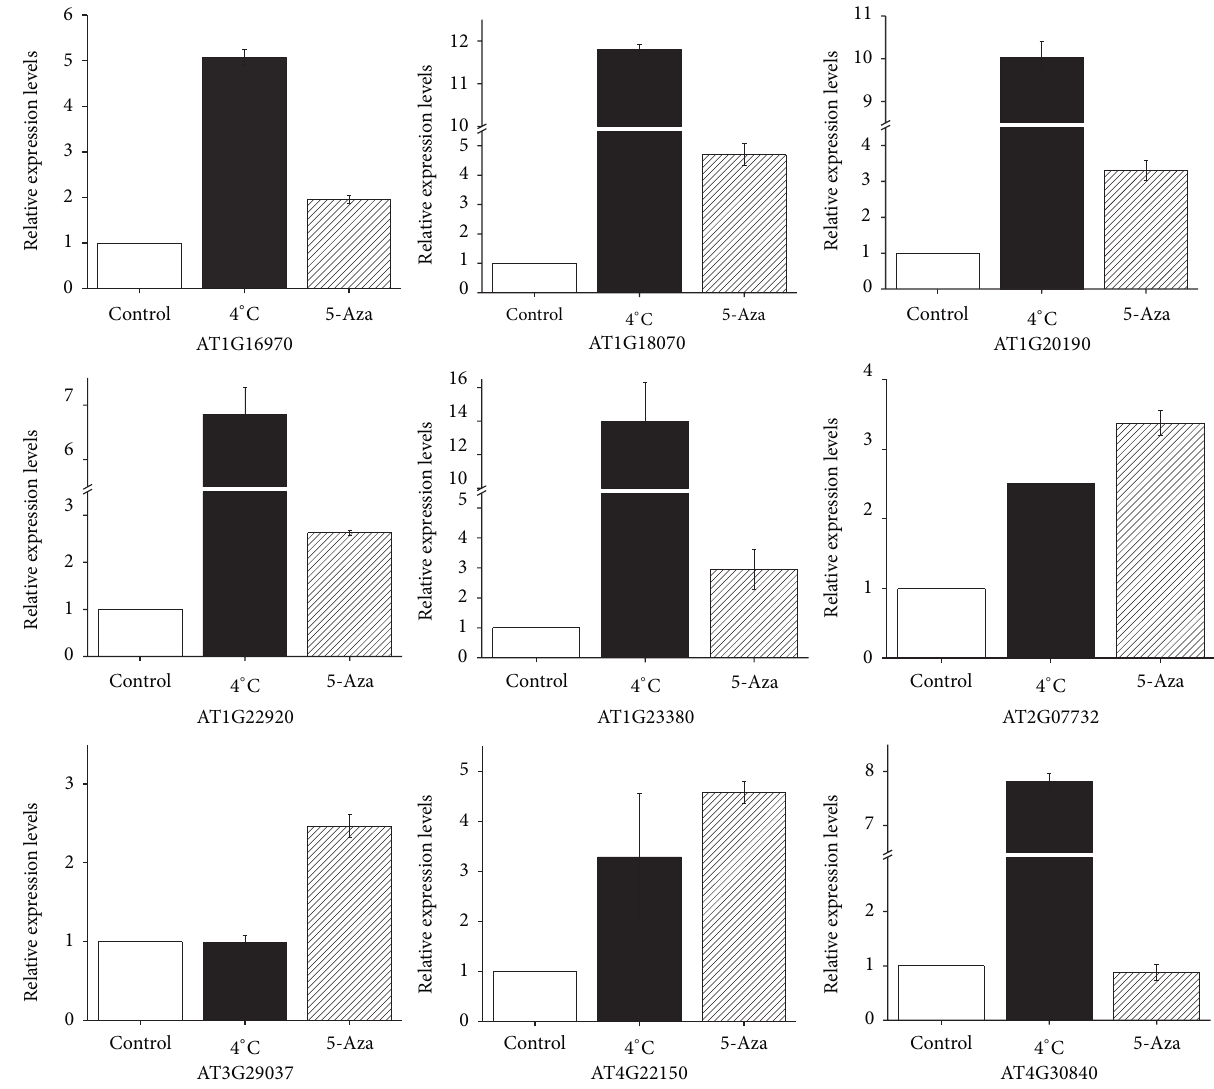
Figure 2: Transcript levels of some genes under different